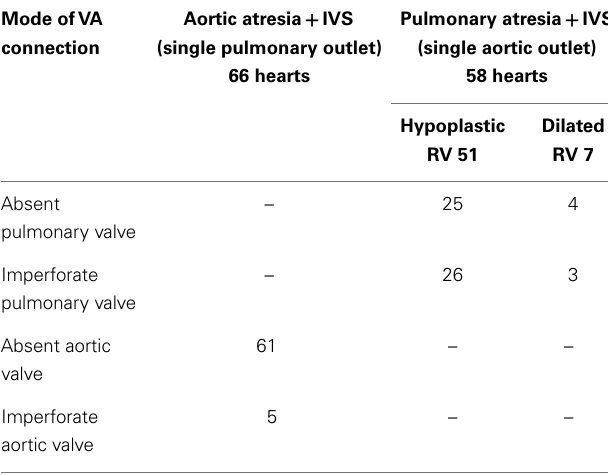
Table 9 | Hearts with biventricularAV connection and singleVA connection: associated anomalies .